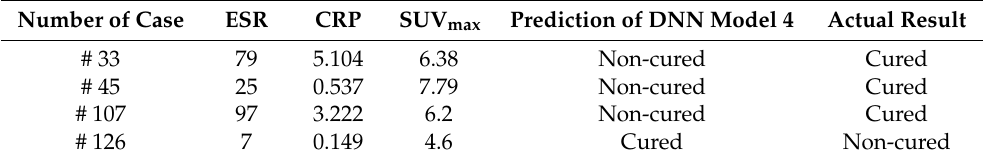
Table 5. Incorrect predictions in DNN model 4.